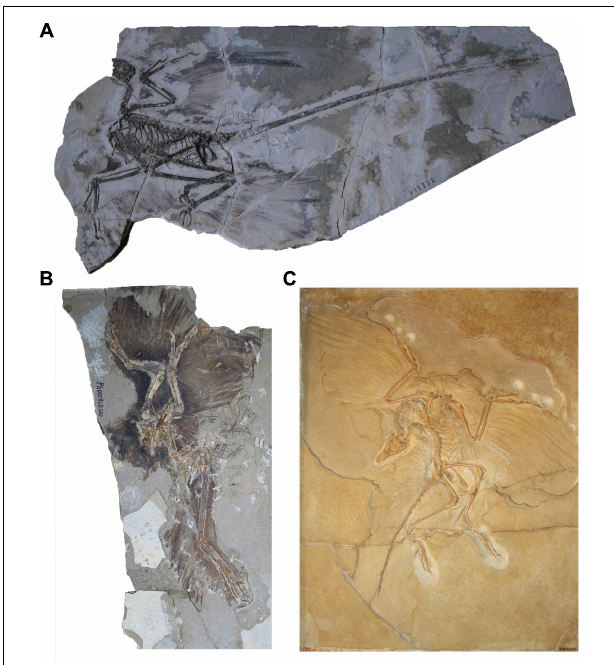
FIGURE 1 | (A) Microraptor zhaoianus (IVPP V123352); (B) Anchiornis huxleyi (BMNHC PH 828); (C) , Archaeopteryx lithographica (MB.AV.100). Not to